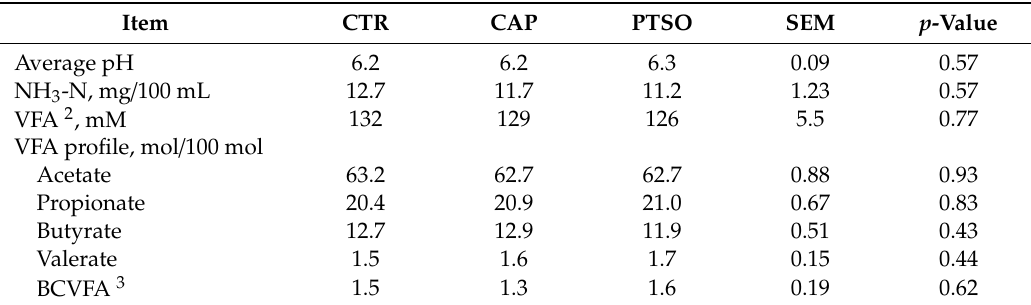
Table 3. E ff ect of propyl-propane thiosulfonate and capsicum oleoresin addition on rumen fermentation characteristics of lactating dairy cow (n = 6) 1